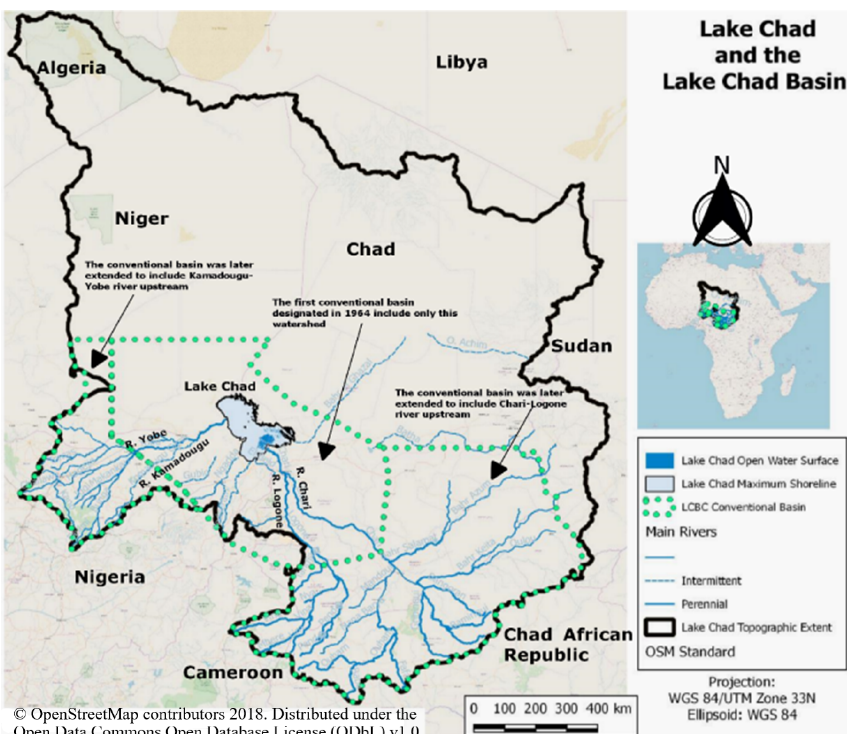
Figure 1. A map showing the conventional basin and the Lake Chad. Modified from International Conference on Lake Chad (© Open- StreetMap contributors 2018. Distributed under the Open Data Commons Open Database License (ODbL)